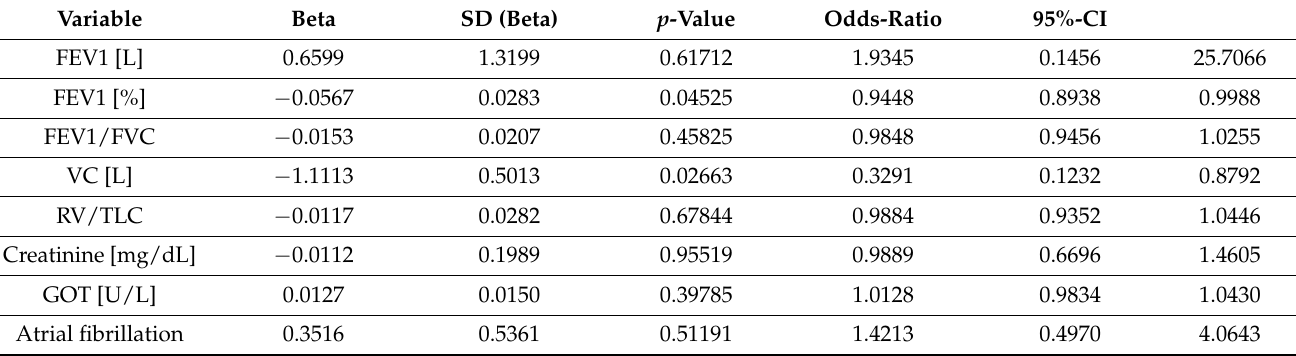
Table 3. Risk factors in multivariate regression analysis (significant in univariate analysis).